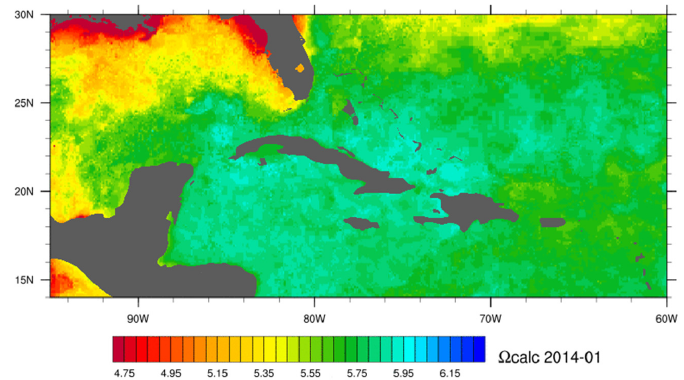
Figure 7. Example of the monthly progression calcite saturation state ( Ω calc) for the Caribbean in 2014 from the NOAA Acidification, Climate, and Coral Reef Ecosystems Team (ACCRETE) product